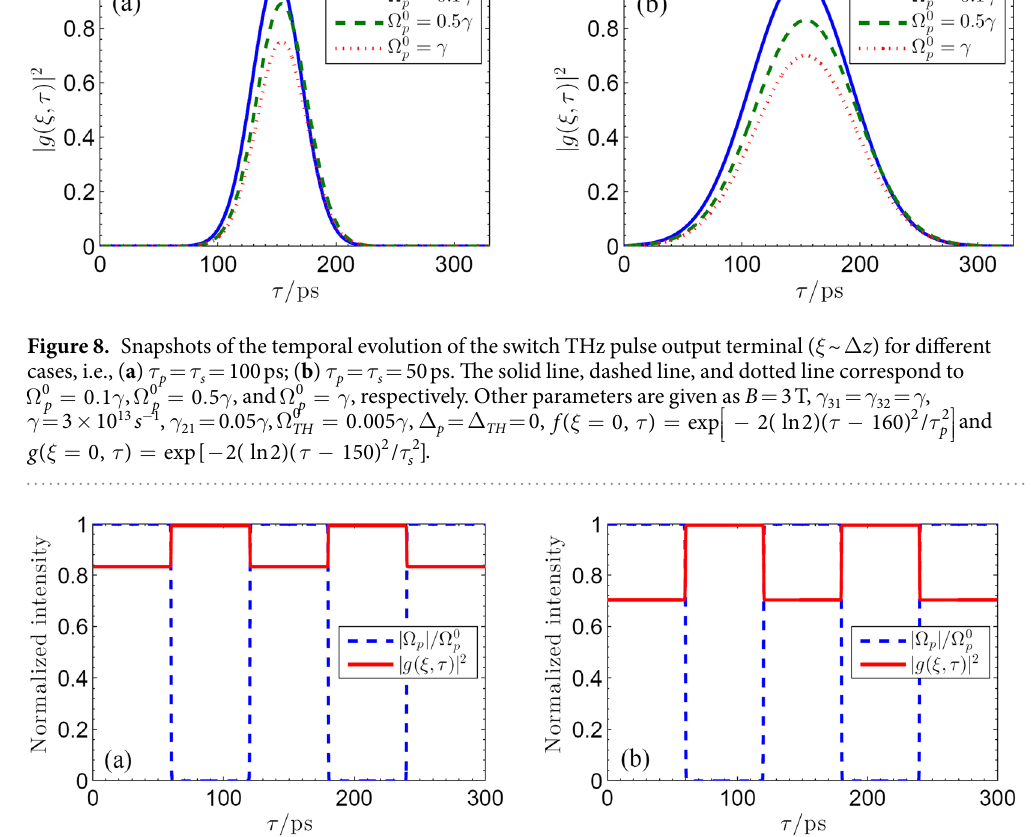
Figure 9. Time evolution of the THz pulse (solid line) at the penetration depth ξ = 10/ β in the sample driven by an infrared probe pulse with wave